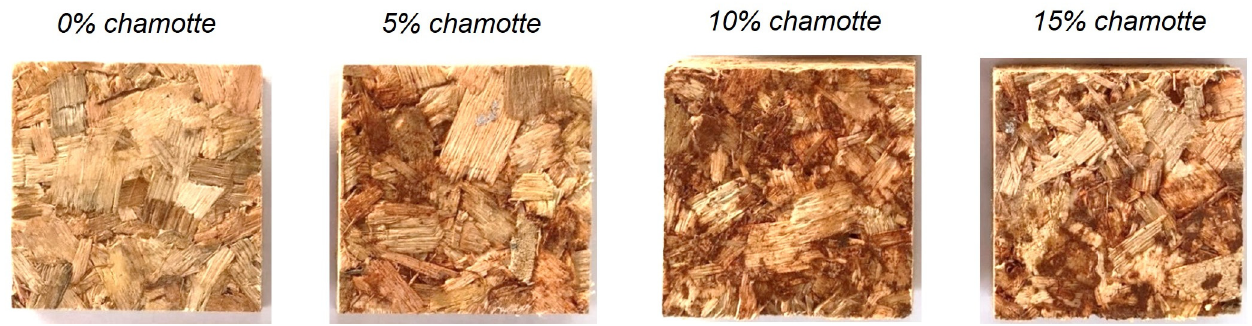
Figure 3. Panels visual comparison with different volume fractions of chamotte.